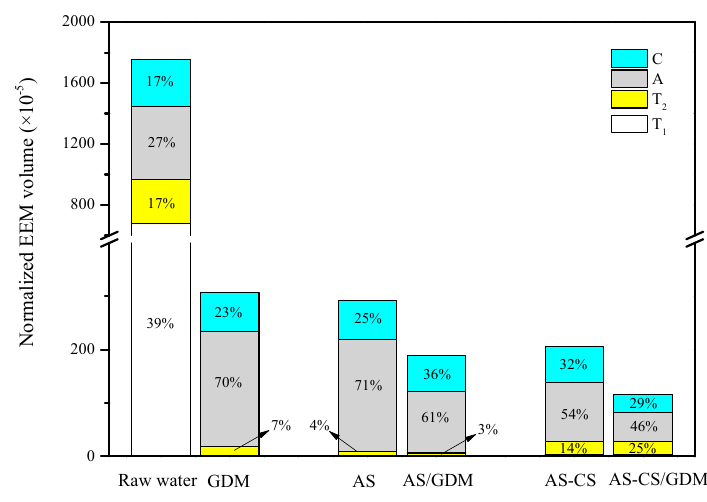
Figure 6. Fluorescence regional integration (FRI) parameters for operationally defined EEM regions in different steps. The condition was the same as that in Figure 5.